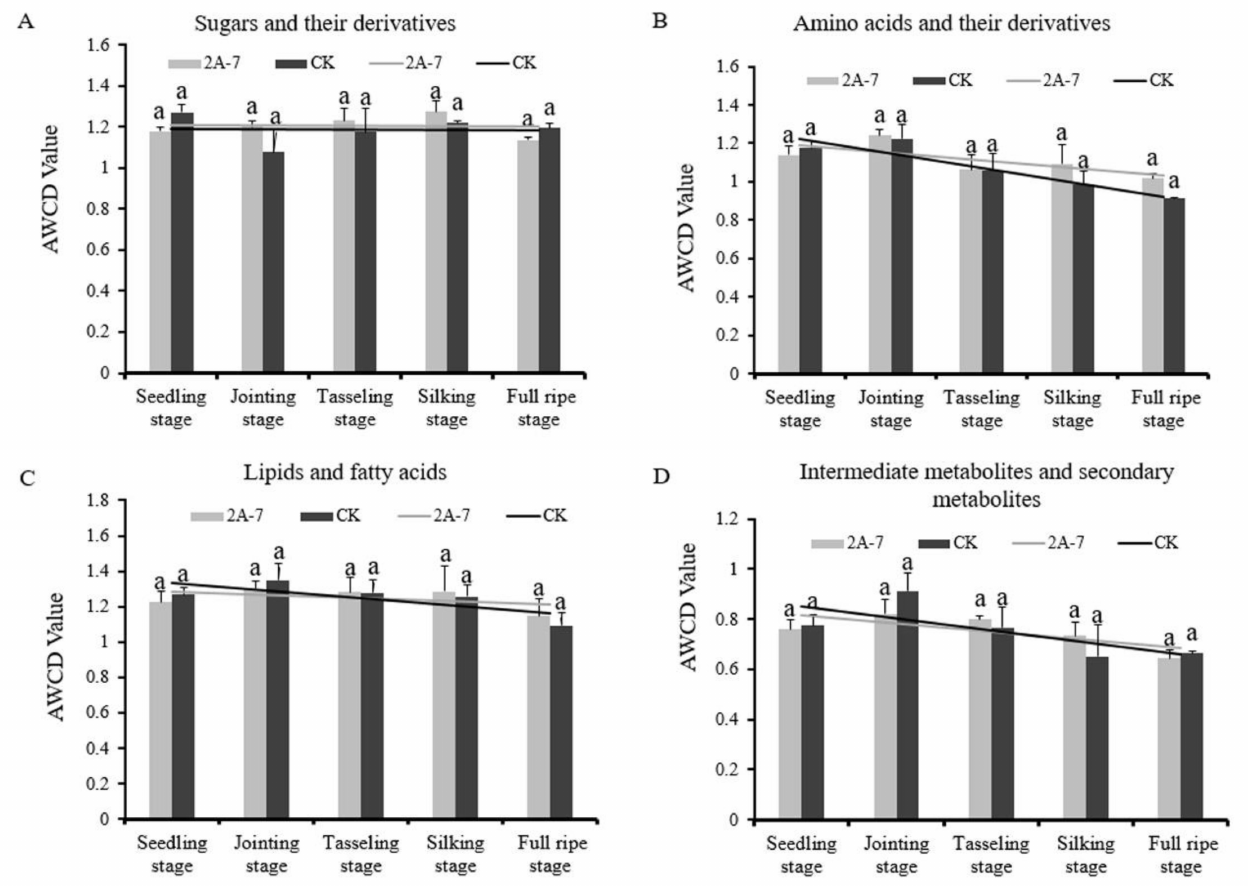
Figure 3. The utilization levels of four types of carbon sources by rhizosphere soil microorganisms of transgenic maize 2A-7 and its non-transgenic control during different developmental